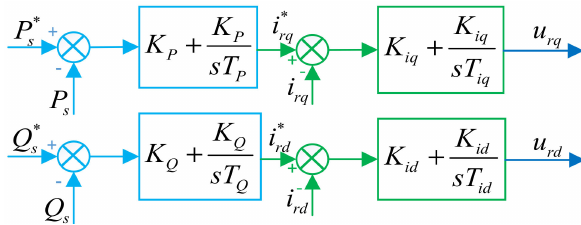
Figure 9. Control structure of PI